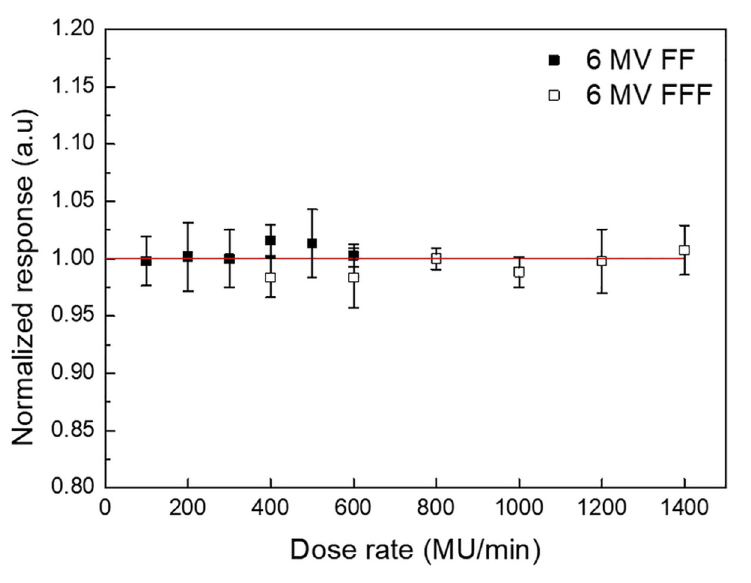
Fig 7. Dose rate dependence of